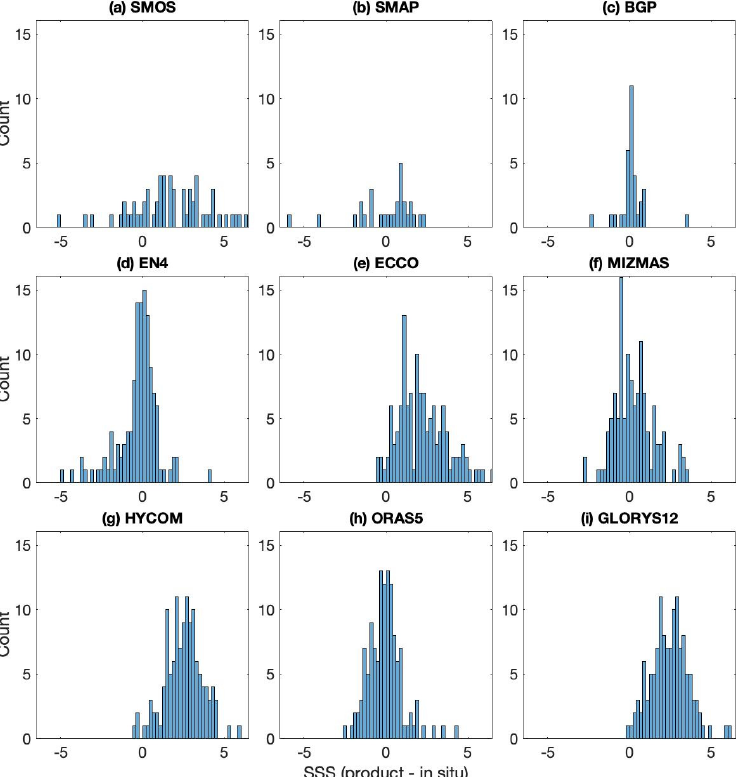
Figure 6. Histograms of sea surface salinity (SSS) differences (psu) of products minus in situ (SIZRS). SIZRS at 2-m is used for ( a , b ) Satellites, and 5-m for ( c , d ) in situ and ( e – i ) models. Bin widths are 0.2 psu. Table 3. Median, mean, standard deviation (Std. Dev.), and Root Mean Square Deviation (RMSD) of SSS differences between products and SIZRS in situ data at each latitude SIZRS measurements were